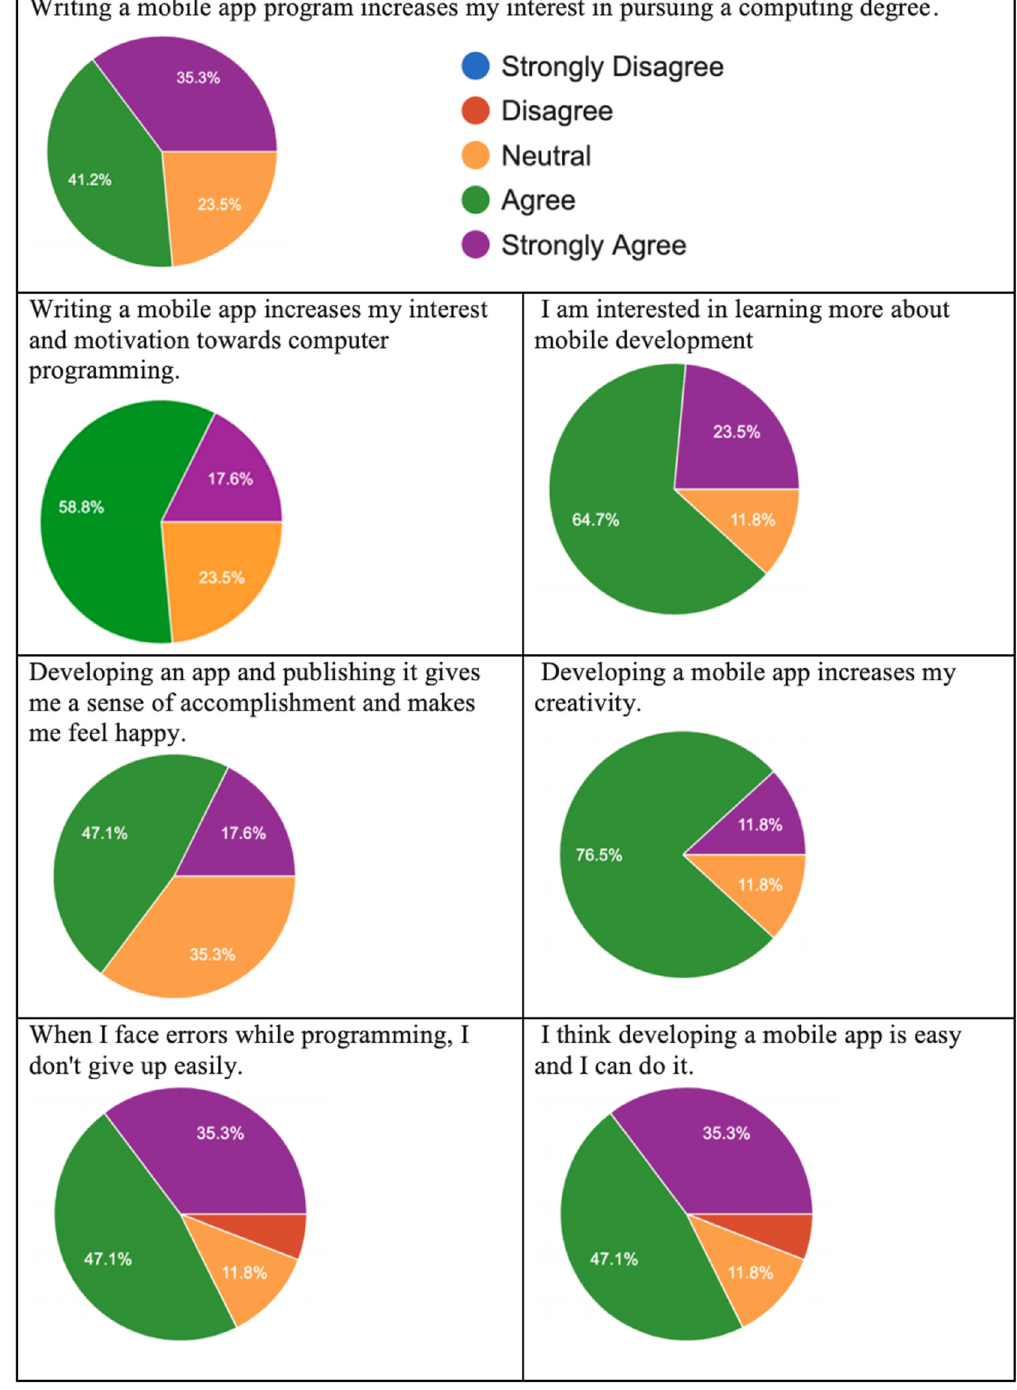
Figure 16. Students’ responses to part of the mobile app development course survey.